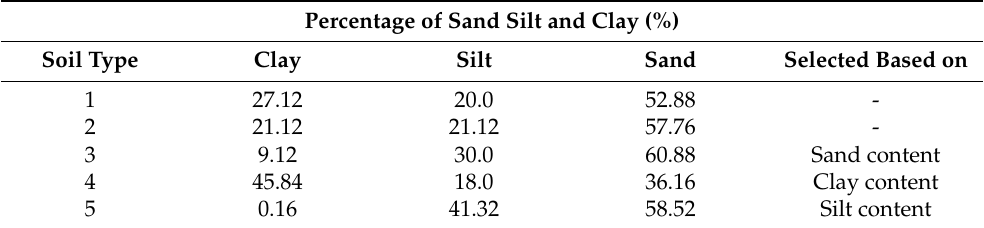
Table 2. Percentage distribution of sand, silt, and clay in selected soil